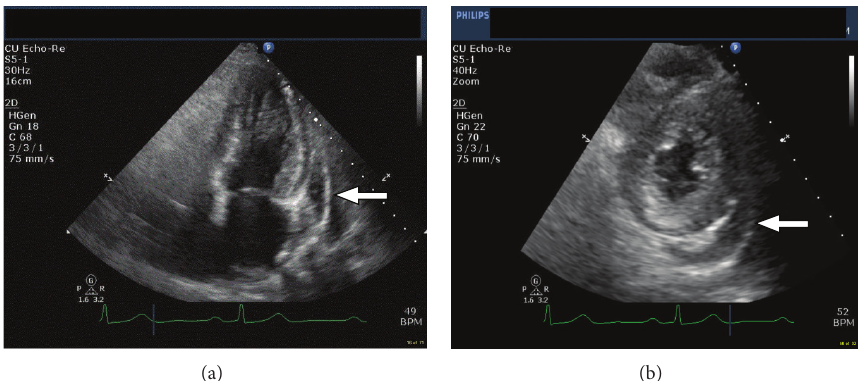
Figure 2: (a) TTE apical long axis view that shows moderate pericardial effusion. (b) TTE midlevel short axis view that shows moderate pericardial